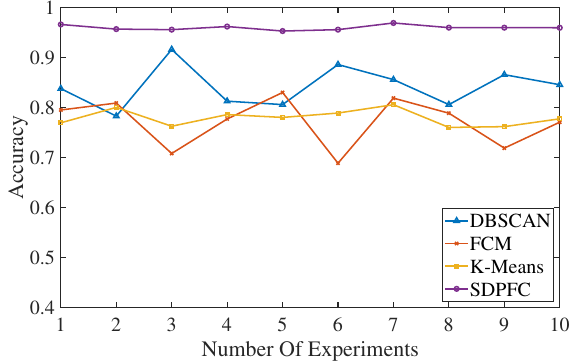
Figure 19. Comparison of stability of each